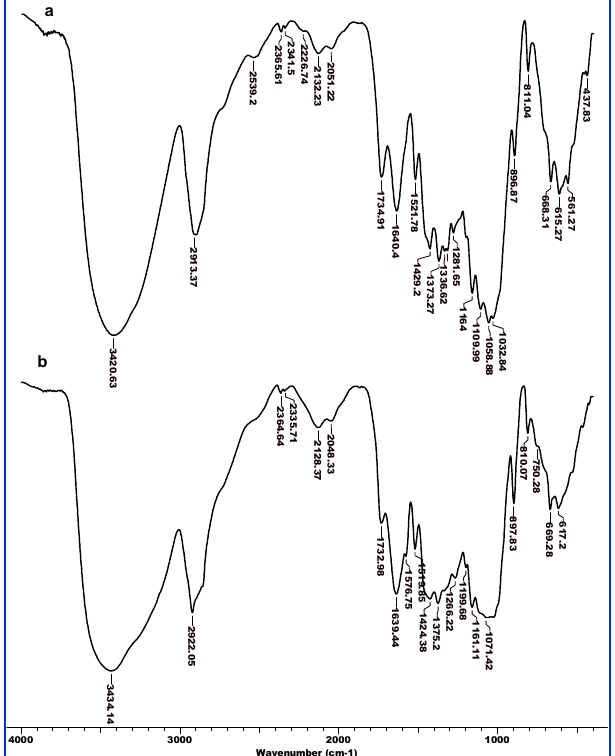
Figure 5. FTIR spectra of wood cellulose from softwood species—fir tree: initial ( a ), and regenerated from ionic liquid solution ( b ).